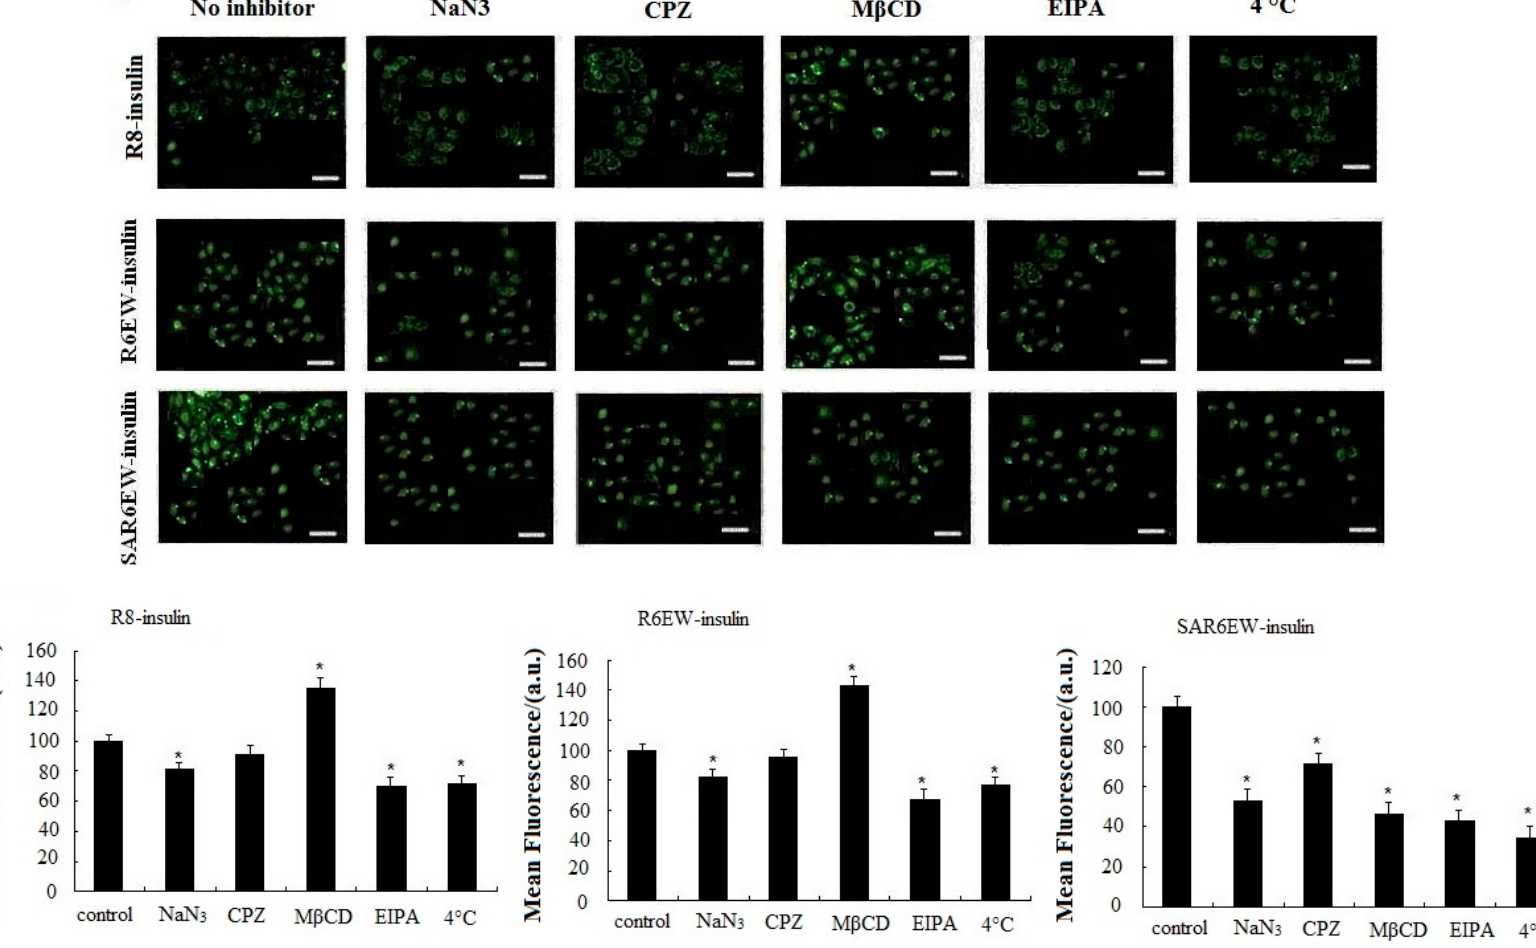
Figure 6. Caco-2 cellular uptake of F-insulin in the presence of various endocytosis inhibitors or at different temperatures analyzed by CLSM ( A ) and flow cytometry ( B ). *: p < 0.05.